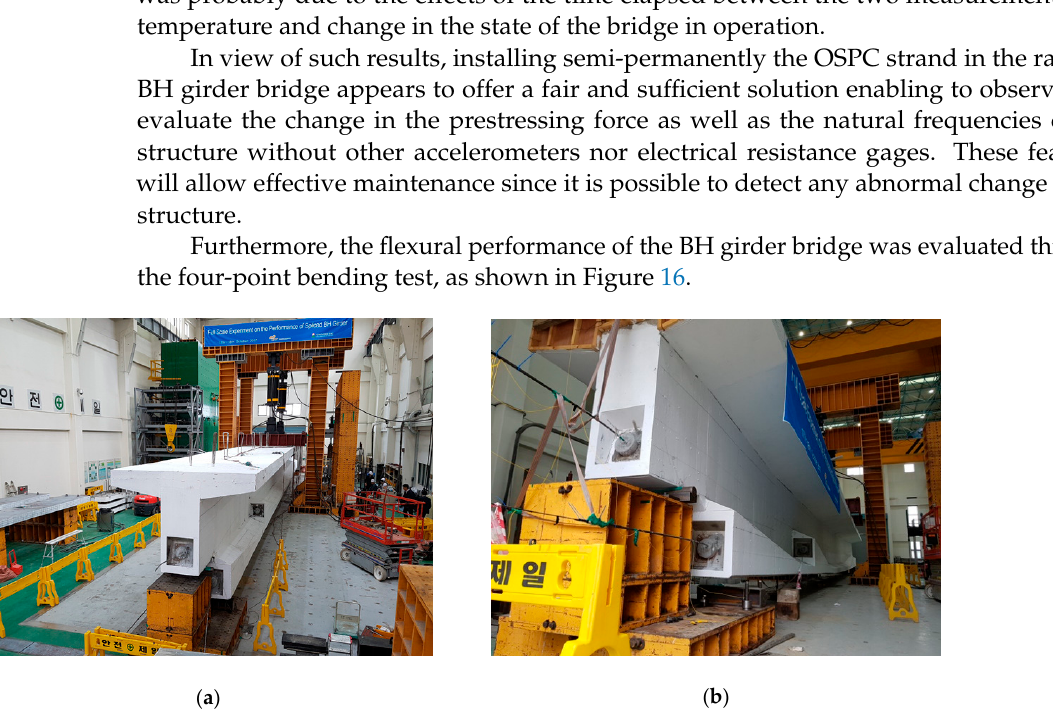
Figure 16. Four-point bending test of BH girder bridge: ( a ) Prototype installed for the test; ( b ) Deflected girder bridge.